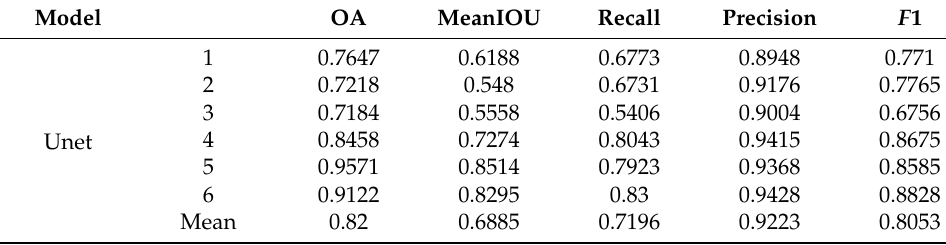
Figure 14. Overview of the results of the experiment for verifying the model’s validity. ( a ) Test image (regions numbered 1,2,3,4,5,6); ( b ) Ground truth; ( c ) The prediction result obtained by Unet; ( d ) The prediction result obtained by our method. Table 5. Quantitative assessment results of the validation